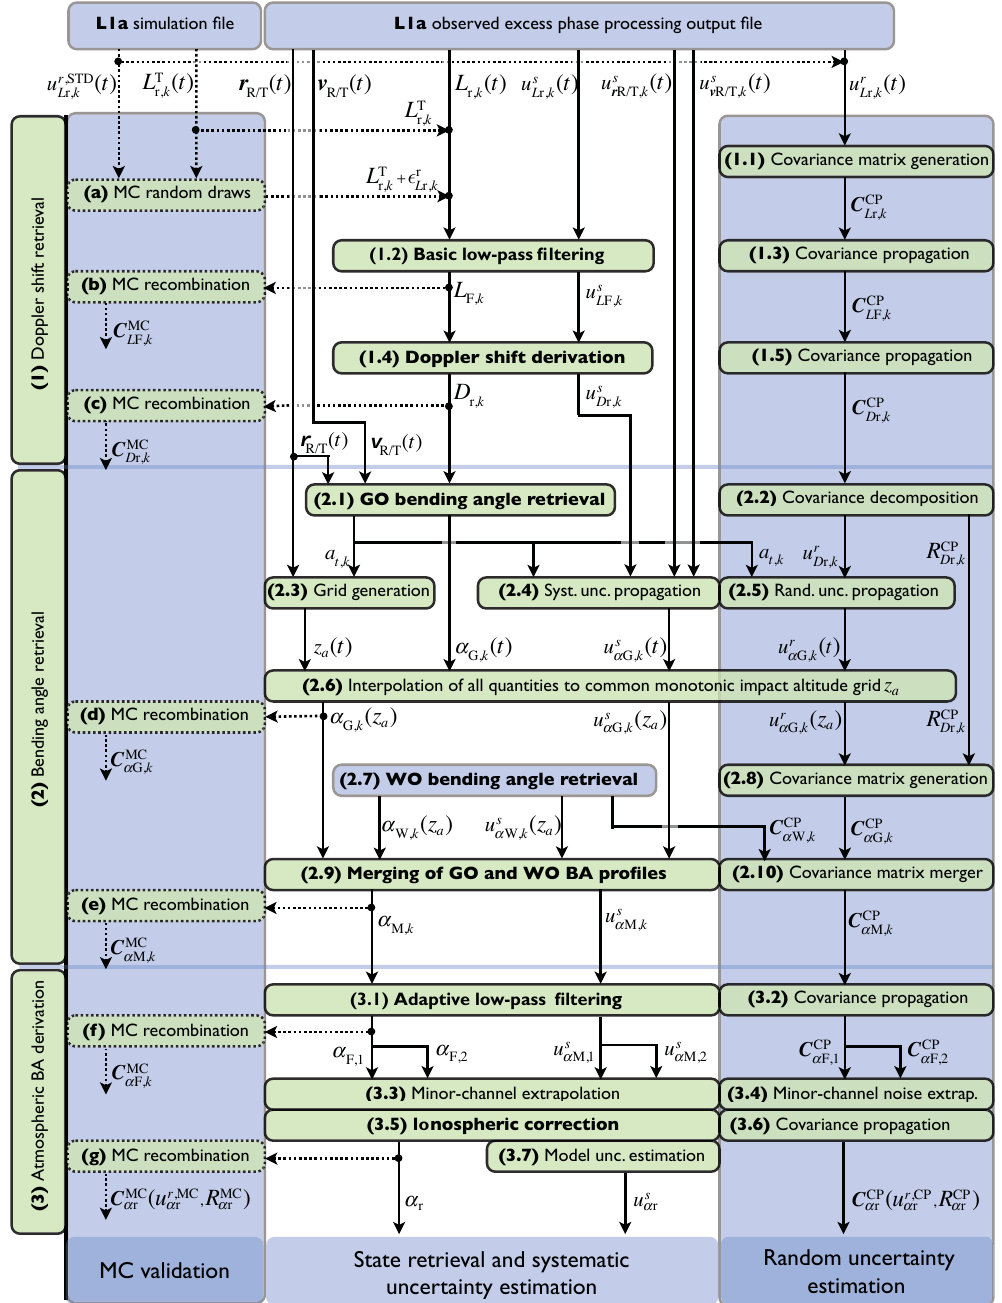
Figure 2. Detailed workflow for state retrieval and uncertainty propagation of the main L1b operators from excess phase to atmospheric bending angle profiles (1)–(3) and of the subroutines used in the MC testing framework (a)–(g). The mathematical notation, including all symbols, is introduced in Tables 1 and